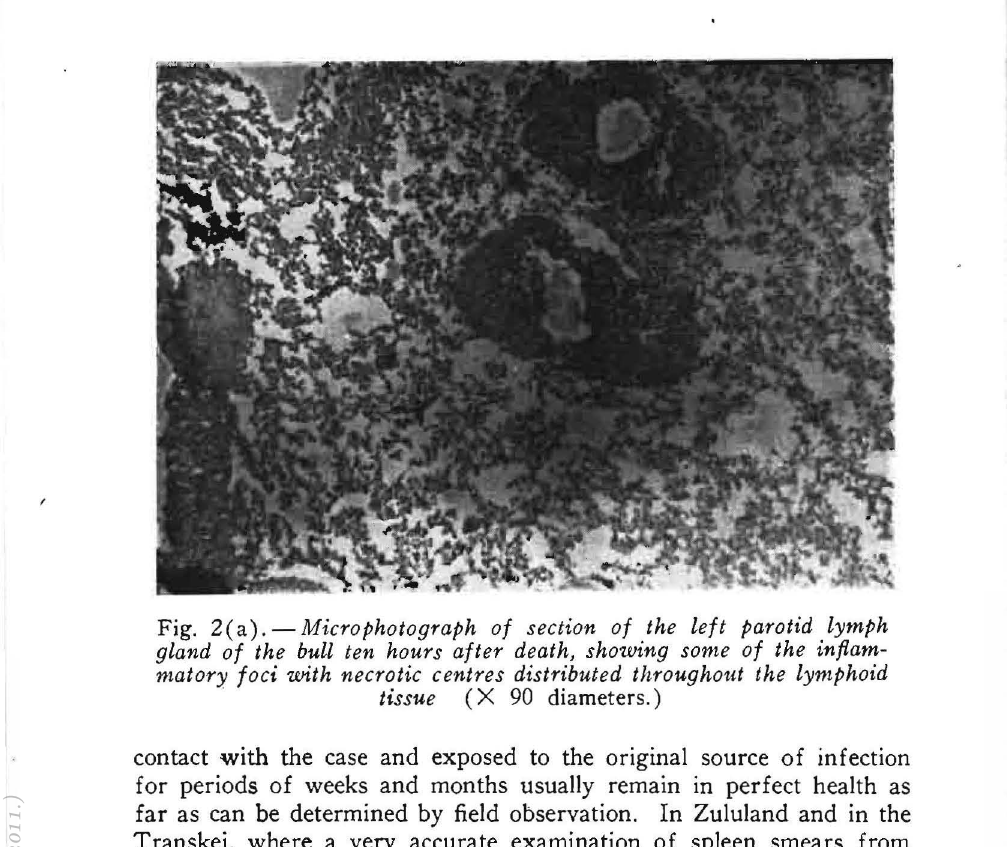
Fig. 2 (a). - Microphotograph of section of the left parotid lymph gland of the bull ten hours after death, showing some of the inflam matory foci with necrotic centres distributed throughout the lymphoid . tissue (X 90